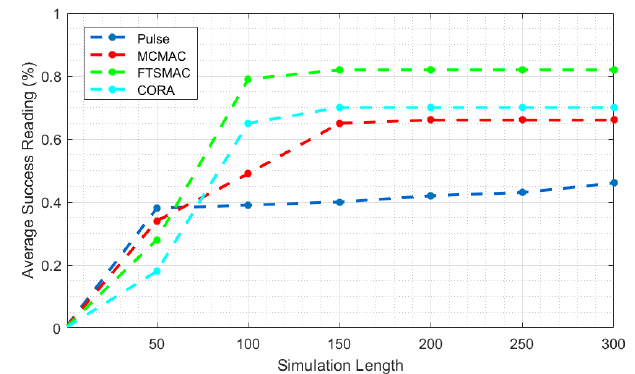
Figure 8. System performance vs. simulation length .